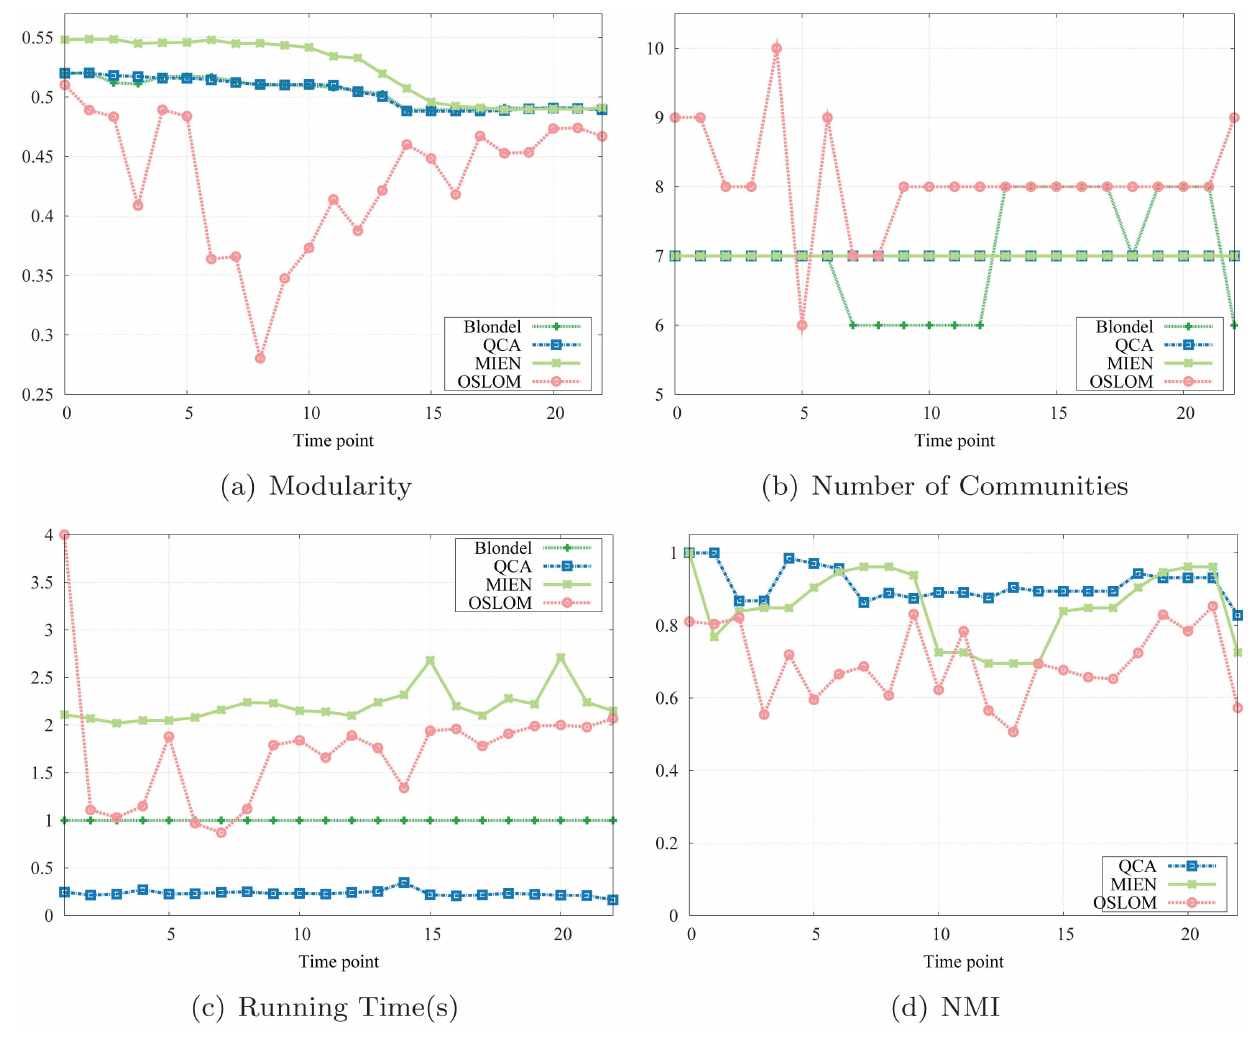
Figure 5. Simulation results on Enron email network.